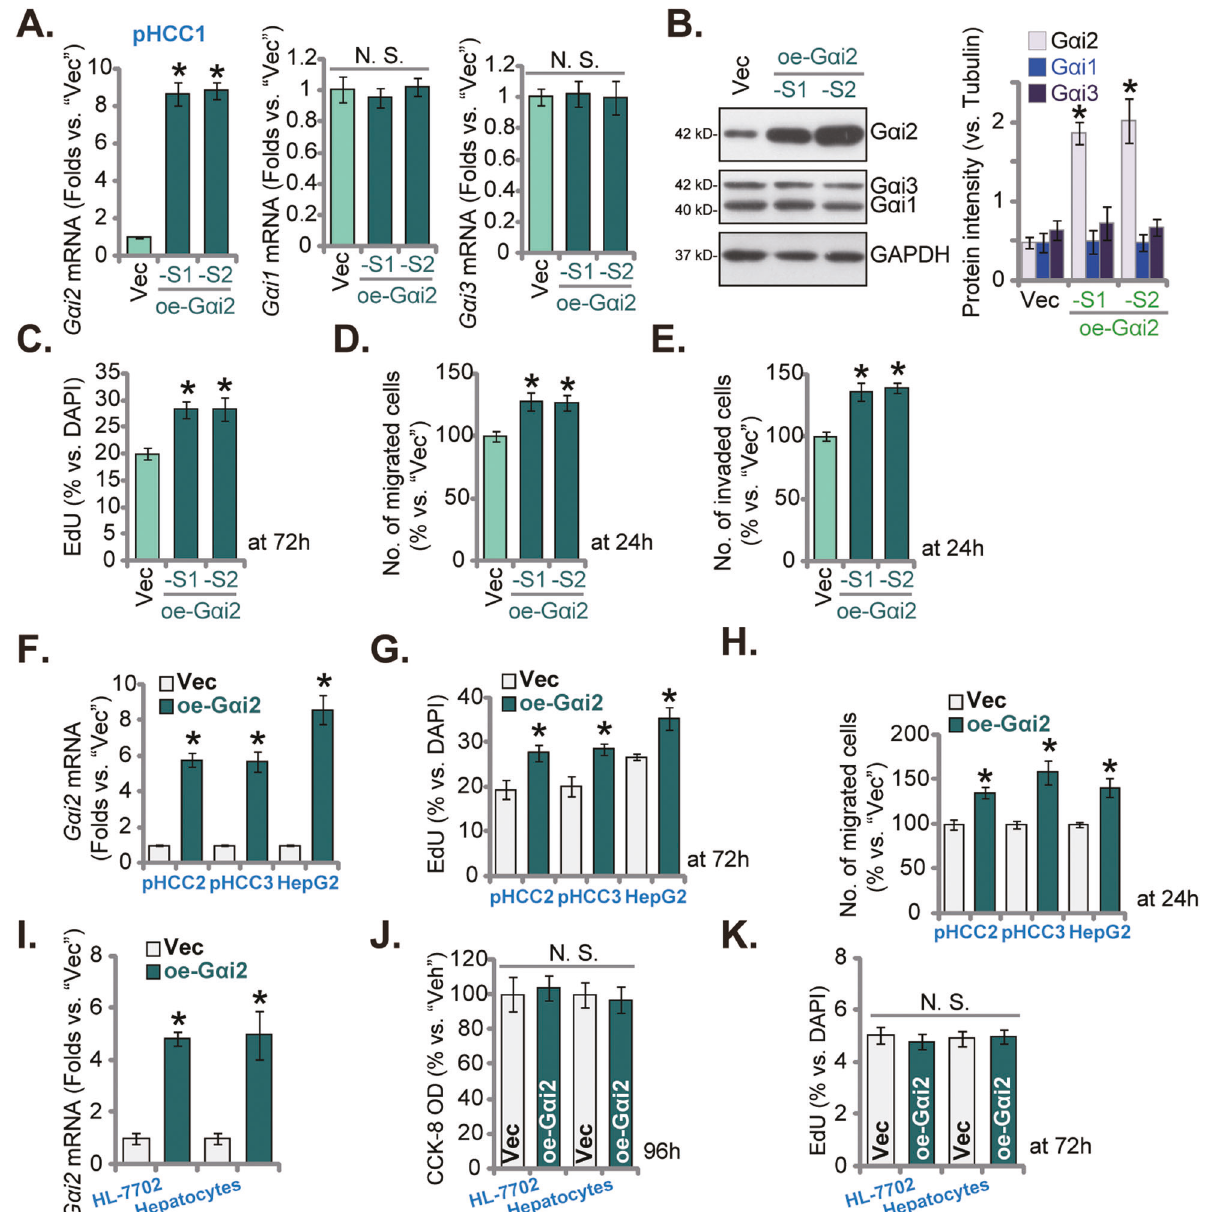
Fig. 6 Ectopic overexpression of G α i2 further promotes HCC cell proliferation and migration. The two stable pHCC1 cell selections, oe- G α i2-S1 and oe-G α i2-S2, with the lentiviral G α i2-overexpressing construct were formed following selection; Control cells were stably transduced with the empty vector ( “ Vec ” ); Expression of G α i1/G α i2/G α i3 mRNAs and listed proteins was tested by qRT-PCR ( A ) and Western blotting ( B ). The exact same amount of viable pHCC1 cells were cultivated for indicated time periods, cell proliferation, in vitro cell migration and invasion were examined by nuclear EdU staining ( C ), “ Transwell ” ( D ) and “ Matrigel Transwell ” ( E ) assays, respectively, with results quanti fi ed. The exact same amount of viable pHCC2 and pHCC3 primary cells, immortalized HepG2 cells, HL-7702 hepatocytes or the primary human adult hepatocytes ( “ Hepatocytes ” ), expressing the lentiviral G α i2-overexpressing construct ( “ oe-G α i2 ” ) or the empty vector ( “ Vec ” ) were cultured, and expression of G α i1/G α i2/G α i3 mRNAs tested ( F , I ). Cells were cultivated for indicated time periods, cell proliferation ( G , K ), in vitro cell migration ( H ) and viability ( J ) were tested similarly. Data were presented as mean ± standard deviation (SD, n = 5). * P < 0.05 versus “ Vec ” cells. “ N. S. ” stands for non-statistical difference ( P > 0.05). Experiments were repeated three times with similar results